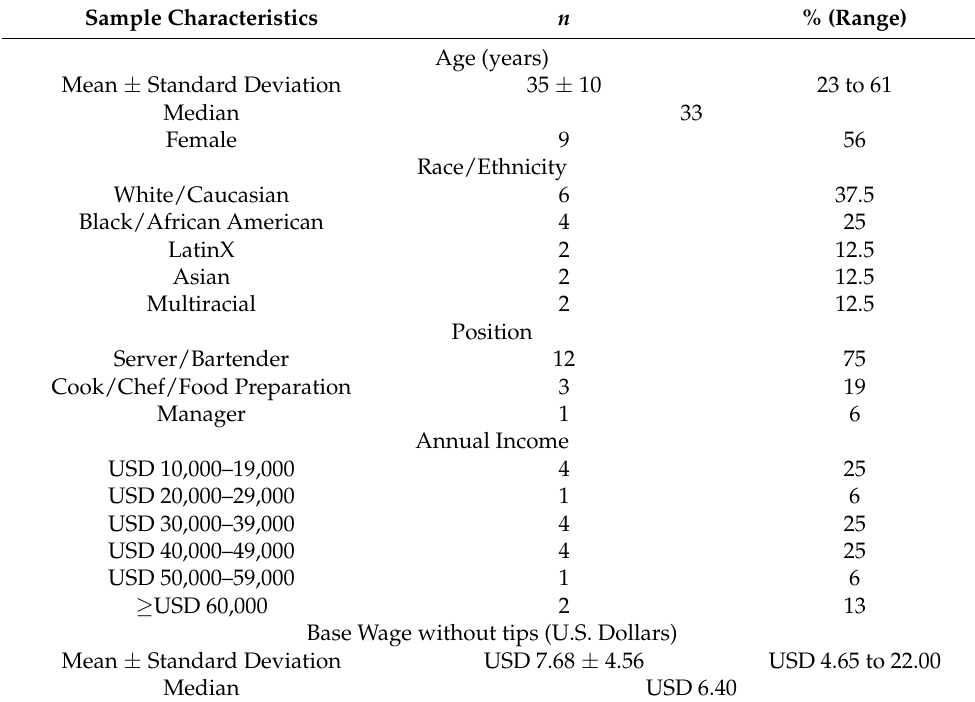
Table 1. Participant overview of restaurant workers interviewed ( n =